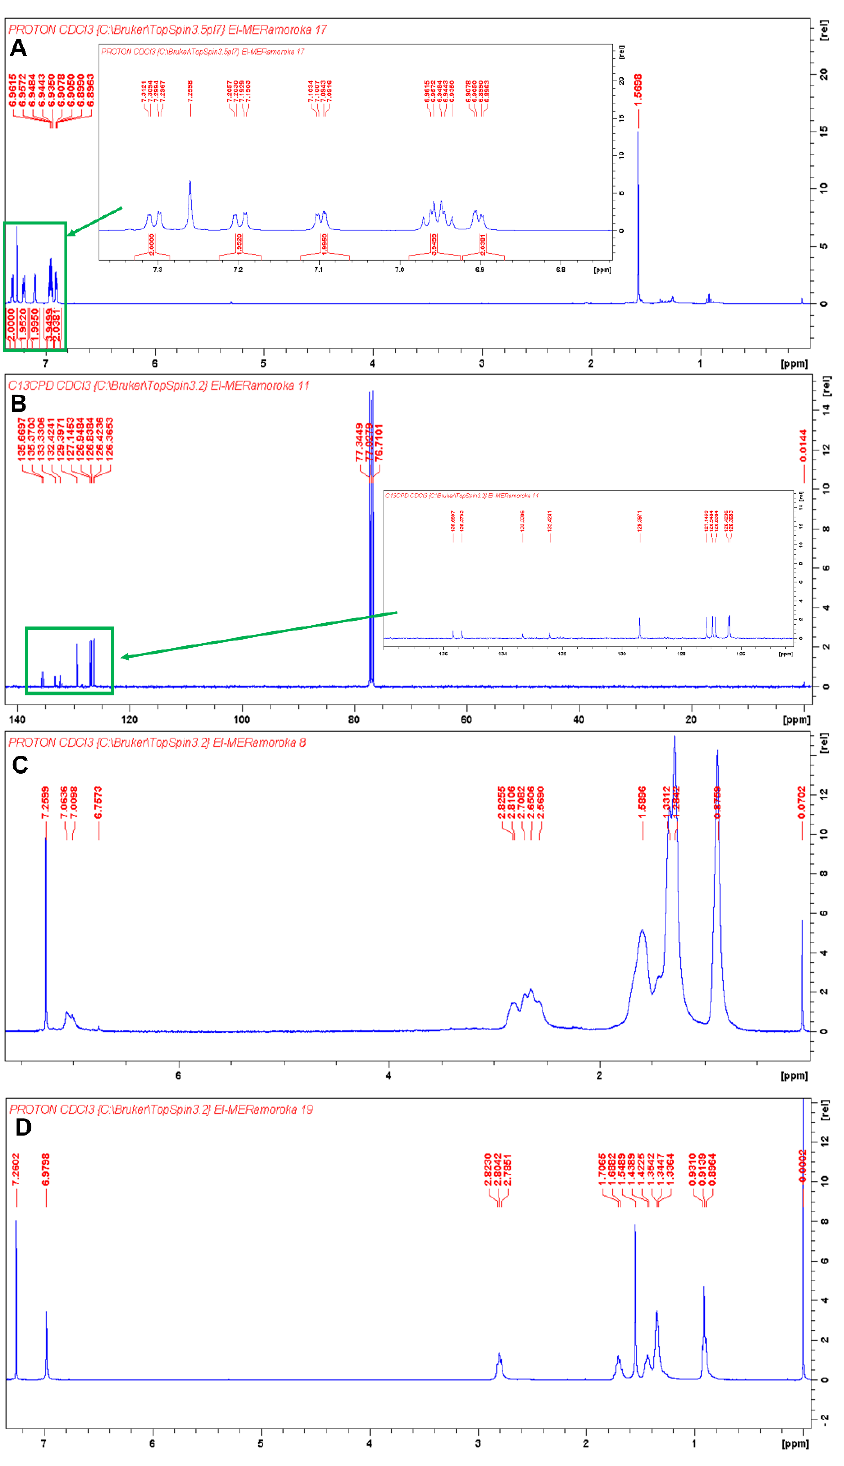
Figure 1. ( A ) 1 H-NMR of TTT in CDCl 3 and the insertion is 1 H-NMR of TTT in the chemical shift range of 6.74 to 7.38 ppm. The signal at 1.5698 ppm is due to the present of water; ( B ) 13 C-NMR of TTT in CDCl 3 and the insertion is 13 C-NMR of TTT in the chemical shift range of 127 to 138 ppm; ( C ) 1 H-NMR of TTT-co-P3HT in CDCl 3 and ( D ) 1 H-NMR of P3HT CDCl 3 . Table 1. Size exclusion chromatography analysis of TTT-co-P3HT.